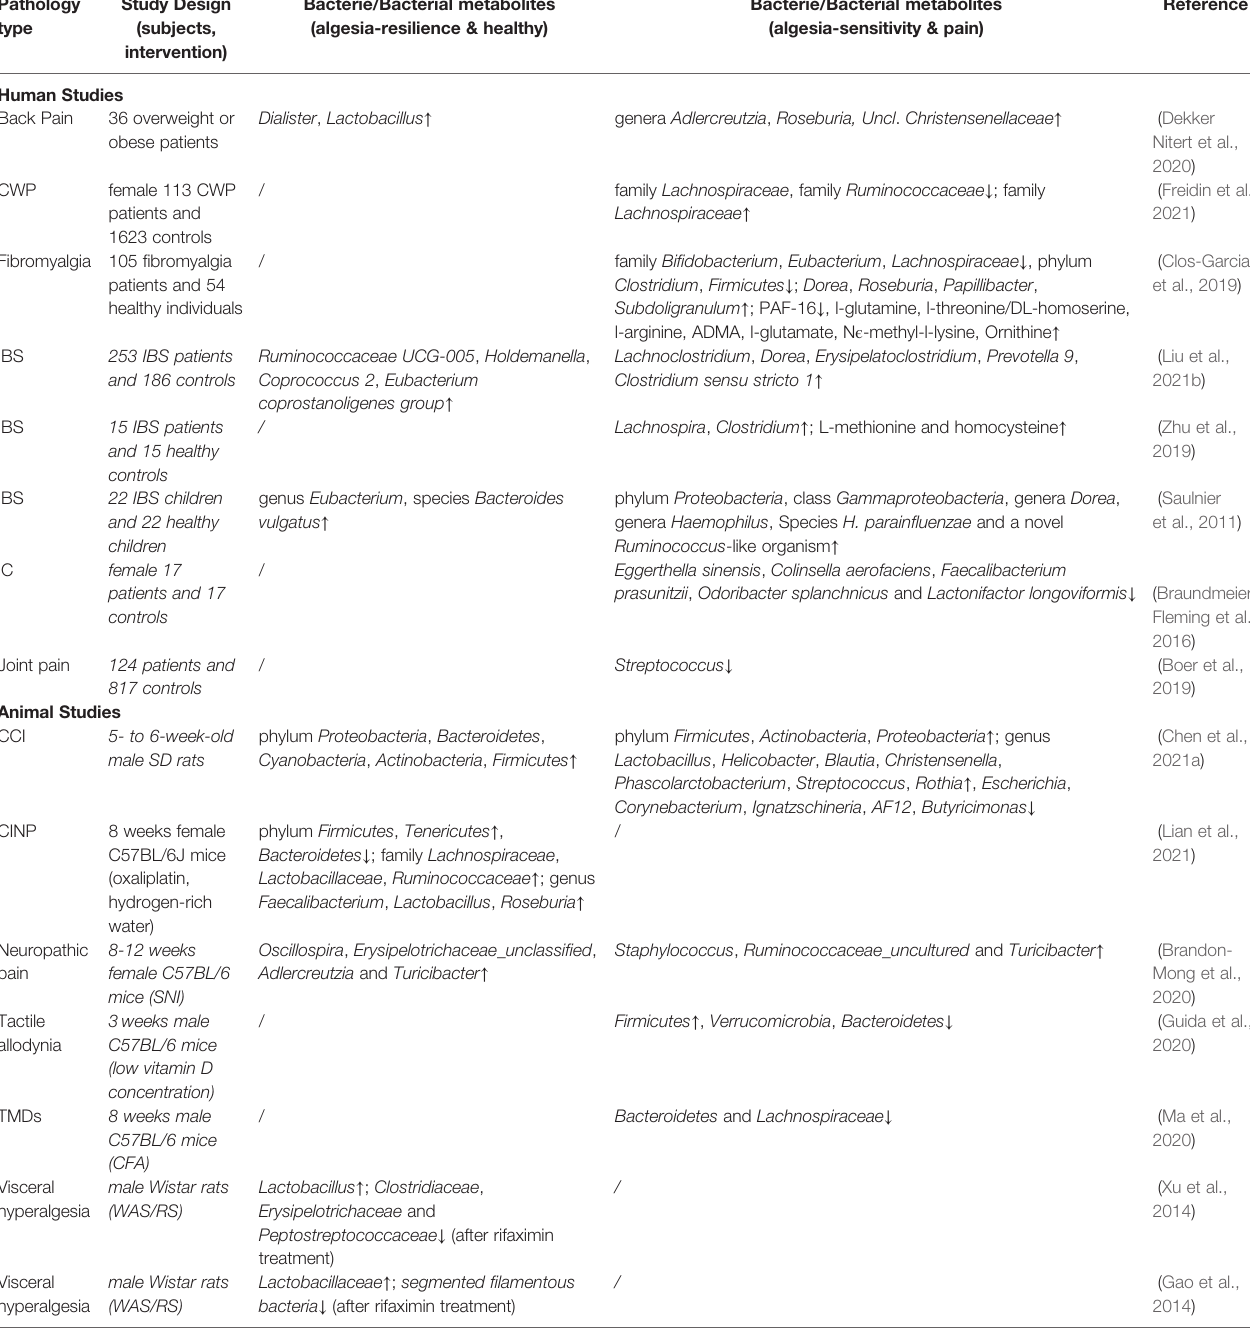
TABLE 1 | Summary of studies investigating links between hyperalgesia and the gut